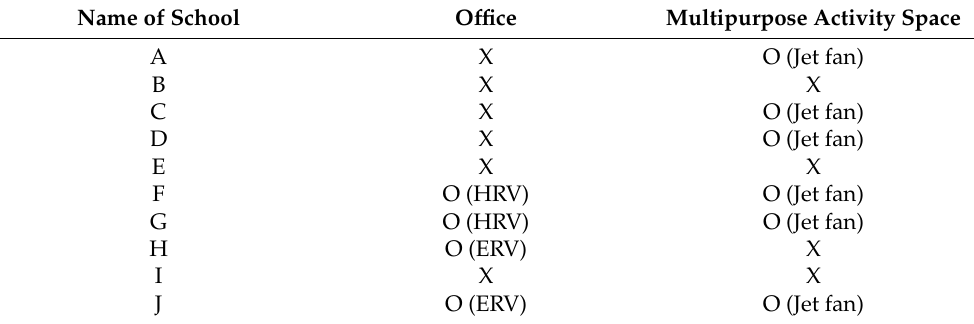
Table 2. Application statuses of air purification facilities in office and multipurpose activity spaces at 10